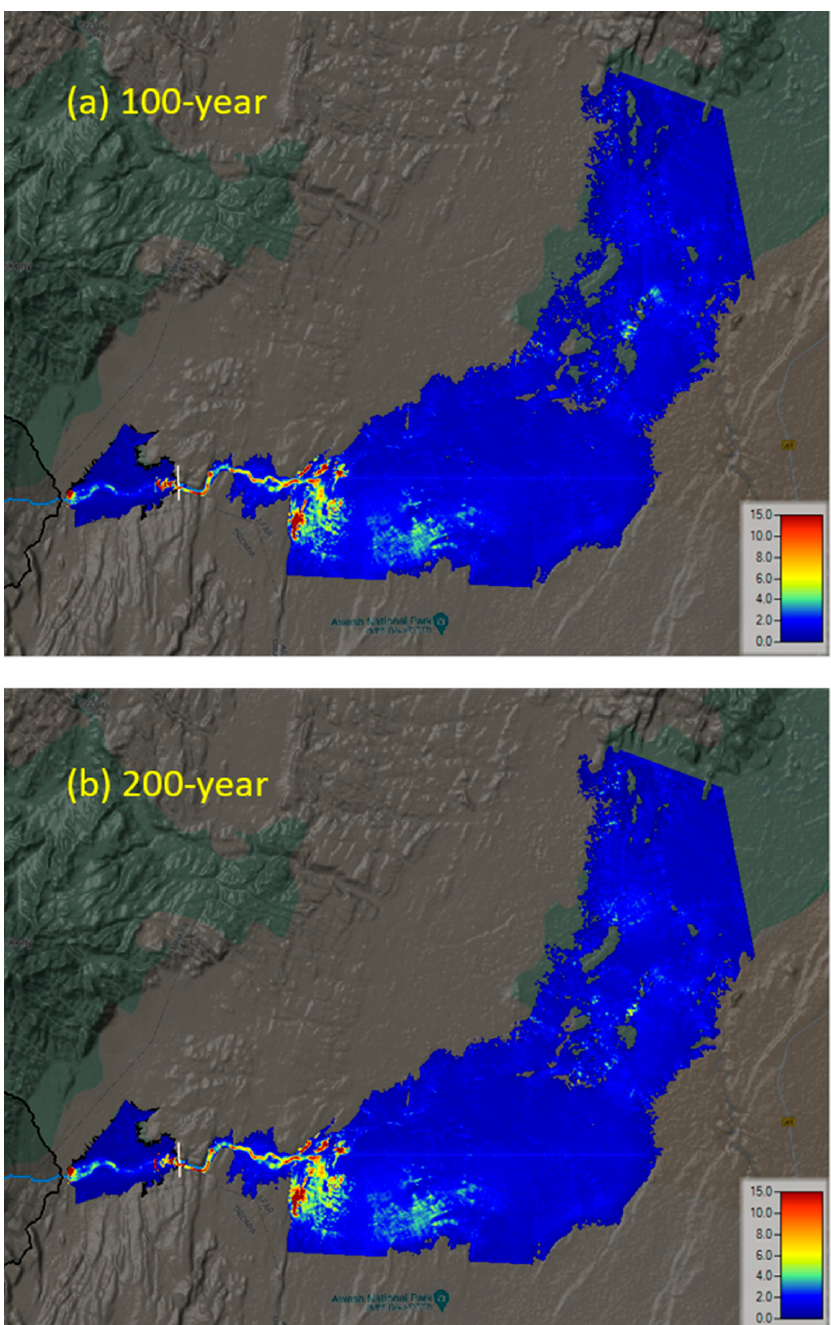
Figure 10. Maximum velocity of flood flow from the dam in the cases of ( a ) 100-year and ( b ) 200-year return period inflows.